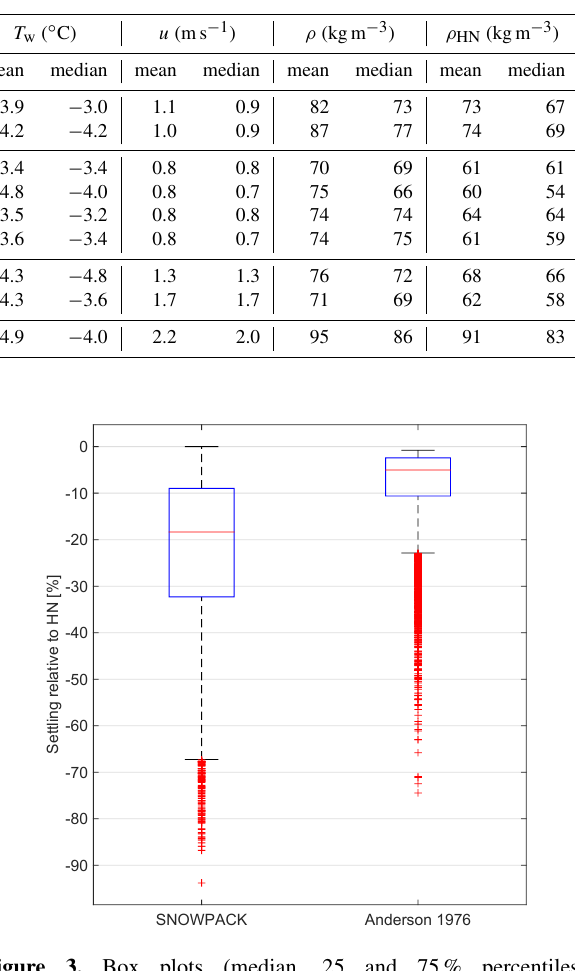
Table 2. Time periods analysed in this study with the mean and the median of hourly values for the height of new snow (HN), wet bulb tem- perature ( T w ) , wind speed ( u ), calculated densities from observed values ( ρ) and calculated densities corrected for settling of the snowpack ( ρ HN ) . The results are valid for the filtered data values ( n th ) with HN>2cm, HNW>1.5mm, T w <0 ◦ C and u <5ms − 1 as a subset of all data that have a precipitation signal and positive HS change ( n P ) .